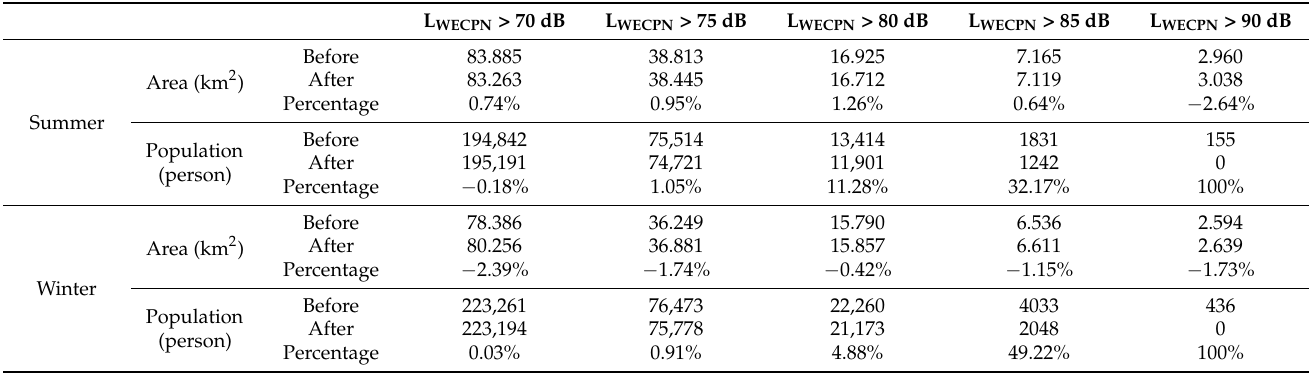
Figure 12. Noise reduction rates by extending the runway during ( a ) summer and ( b ) winter. Table 5. Noise reduction effects by extending the runway during summer and